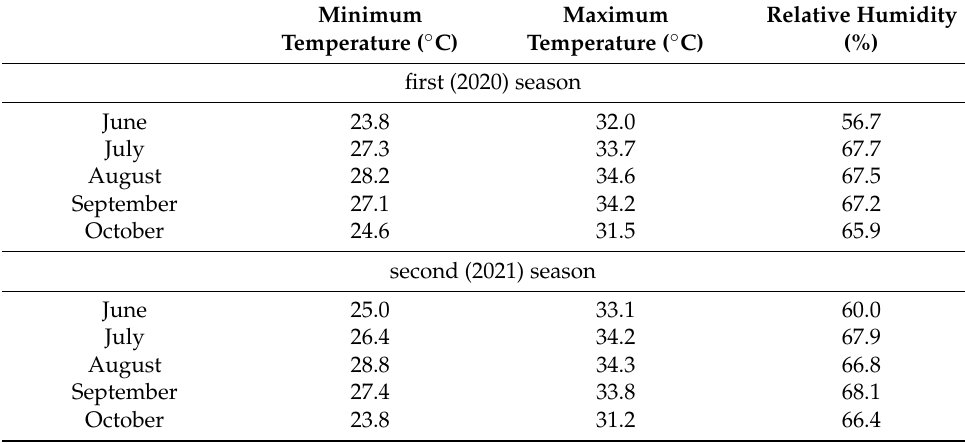
Table 1. The annual climatological datasets in the 2020 and 2021